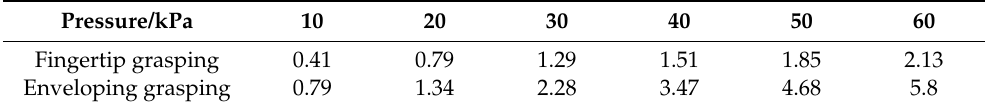
Figure 17. Experiment of fingertip grasping and envelope grasping. ( a ) Experimental diagram of grasping. ( b ) Experimental diagram of fingertip grasping ( c ) Experimental diagram of envelope grasping. Table 3. The end-output force of fingertip grasping and envelope grasping.